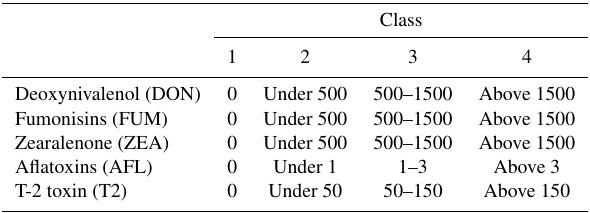
Table 2. Characteristics of classes of individual mycotoxins based on their content (ppb) in individual feedstuff